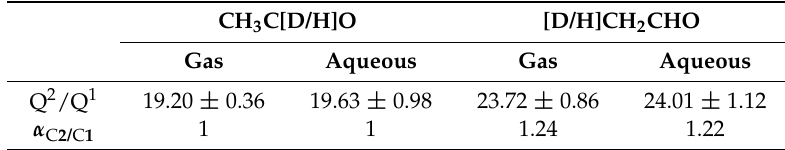
Table 2. Computed ratio of 2 H/ 1 H partition functions and equilibrium isotope fractionation factor of CH 3 CHO in the gas phase and in aqueous solution at 25 ◦ C and 1 atm using the PM3/TIP3P QM/MM